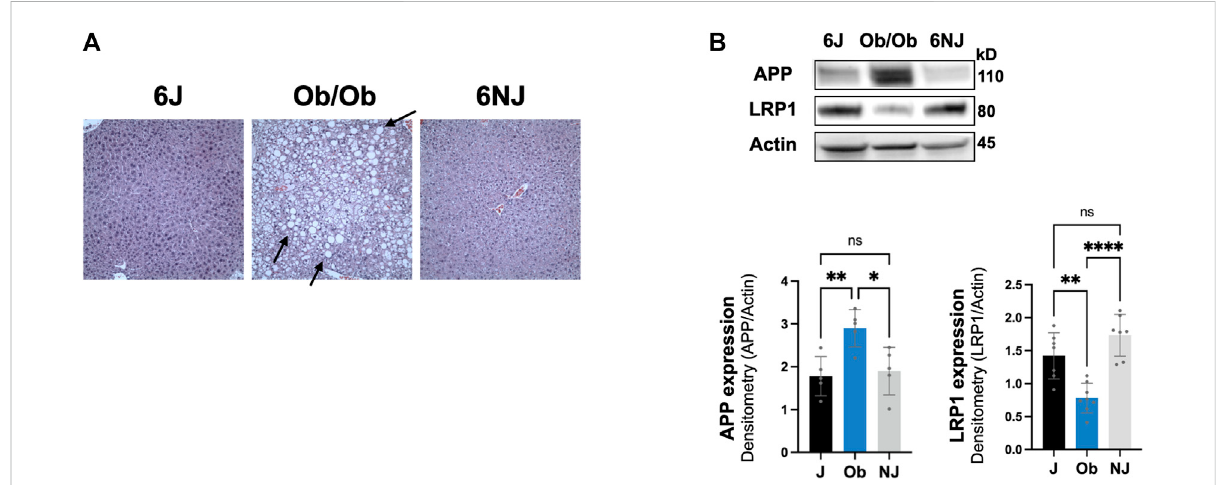
FIGURE 6 Expression of LRP1 and APP in ob/ob steatosis mice. (A) Representative H&E histology (×200 magni fi cation) of ob/ob mice liver and control mice(J,NJ)at20 weeks ofage.The arrows pointtolipid dropletsintheliverassociatedwith steatosis. (B) LRP1andAPP expression intheliverofob/ ob with advance steatosis. n = 6 mice per group. 6J and 6NJ represent two different control mice for ob/ob mice. Results are mean ± SD; **** p < 0.0001, ** p < 0.01, or * p < 0.05 vs. J or NJ